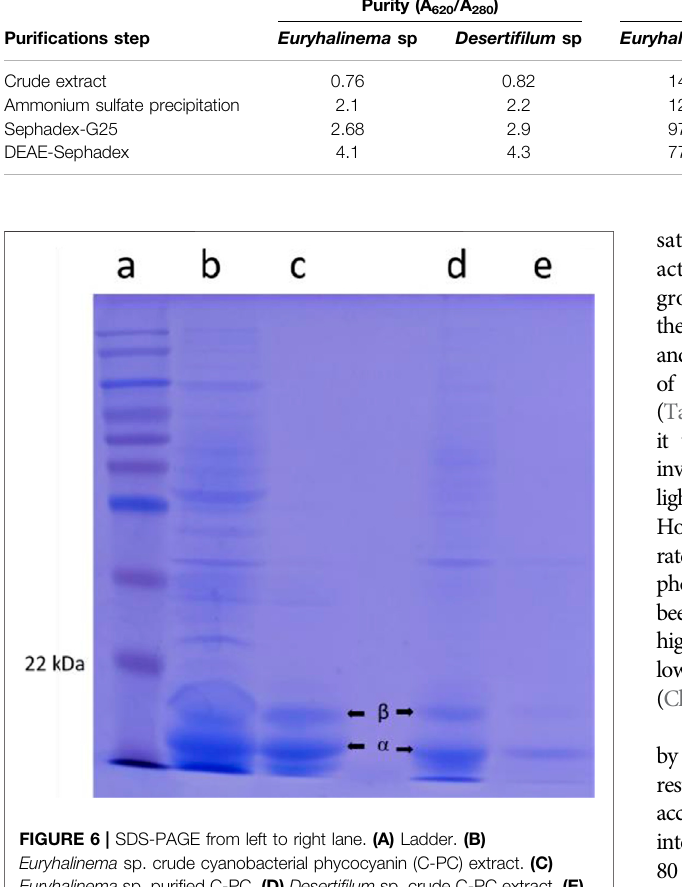
Frontiers in Bioengineering and Biotechnology |